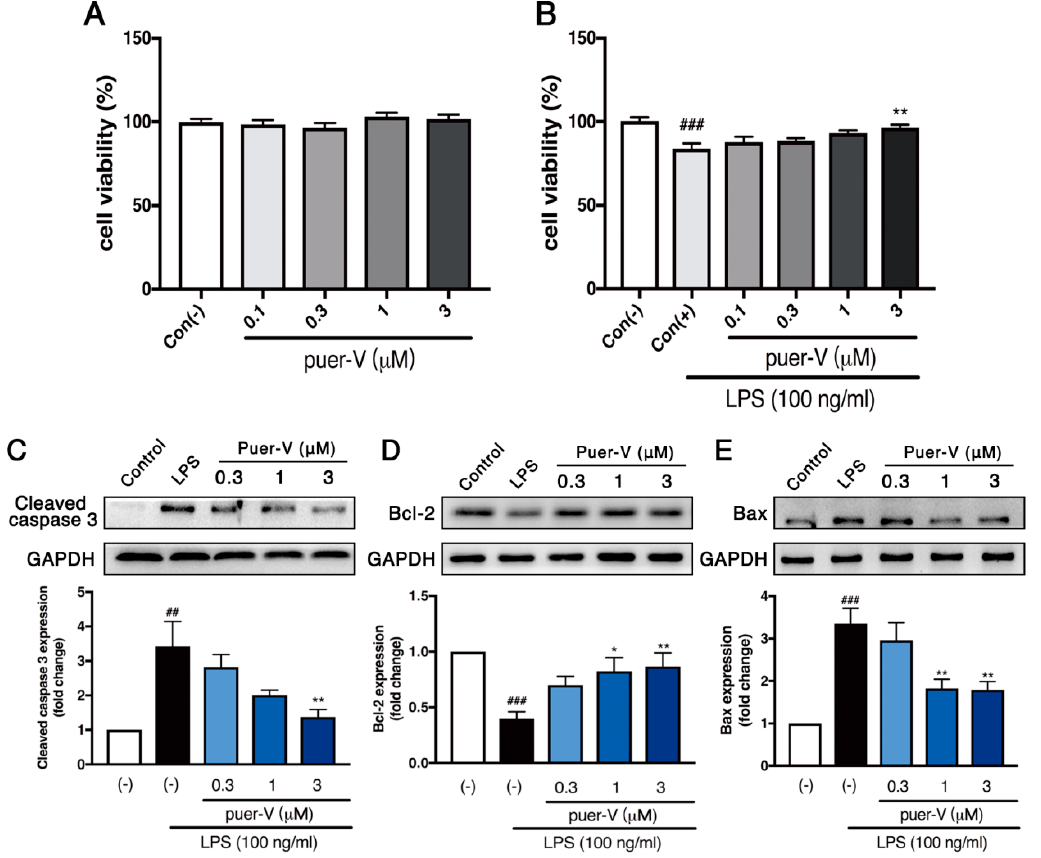
Figure 8. Effects of puerarin-V on cell viability and apoptosis-related protein expression in HCAECs exposed to LPS. ( A ) Effects of puerarin-V on cell viability under normaxia conditions. ( B ) Effects of puerarin-V on cell viability in LPS-induced cell injury. ( C ) Cleaved caspase 3 expression. ( D ) Bcl-2 expression. ( E ) Bax expression. Relative density analysis of the protein bands was shown by the western blot with GAPDH as control. Data are shown as mean ± SEM ( n = 4). ## p < 0.01, and ### p < 0.001 vs. control group. * p < 0.05, and ** p < 0.01 vs. model